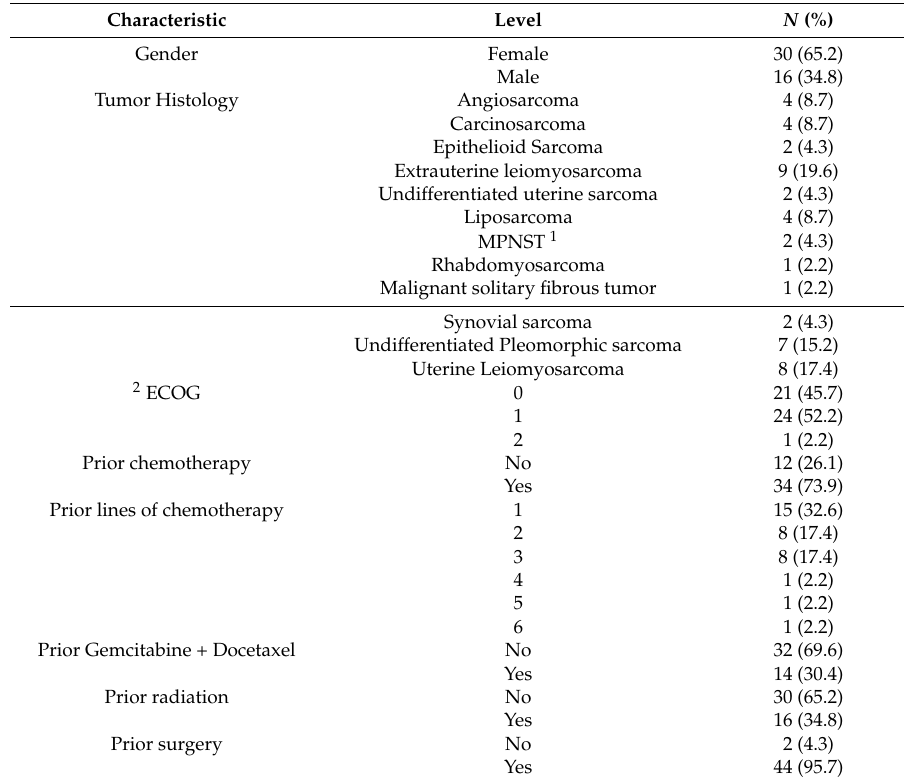
Table 1. Baseline patient characteristics and patient